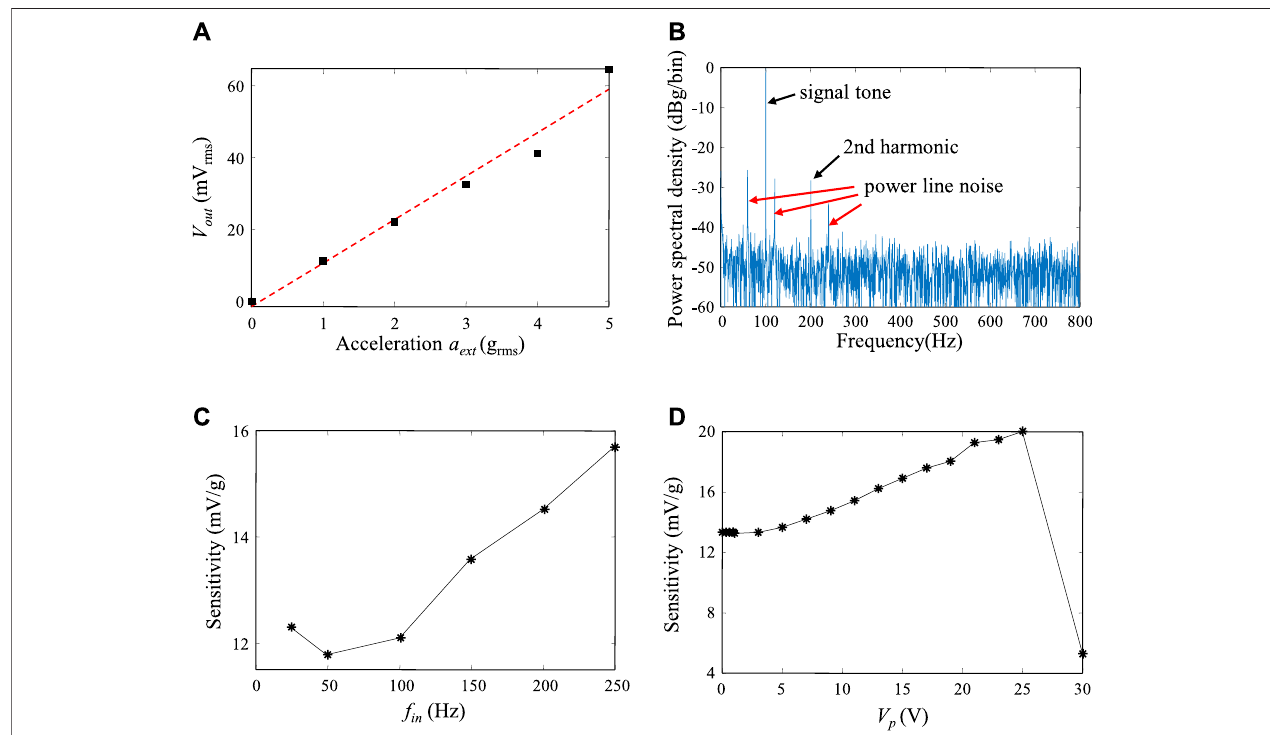
FIGURE13| Dynamicaccelerationtestresults, (A) V out vs a ext for f in =100 Hzand V p =0 V, (B) outputpowerspectraldensityfor a ext =1g rms , f in =100 Hzand V p = 0 V, (C) sensitivity for a ext = 5 g rms and V p = 0 V, (D) recon fi gurability/tunability test for a ext = 5 g rms and f in = 100 Hz.